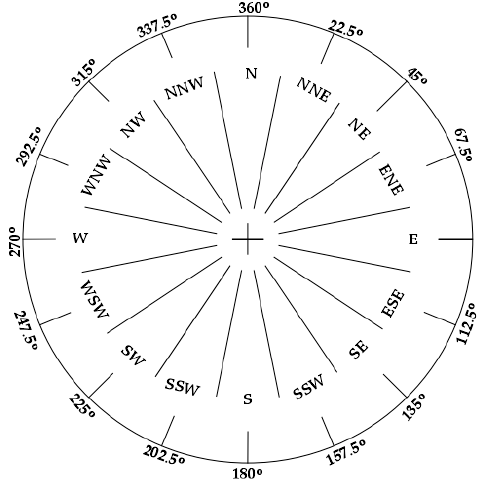
Figure 2. The 16-wind rose